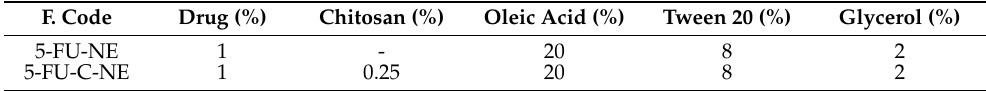
Table 4. Composition of the